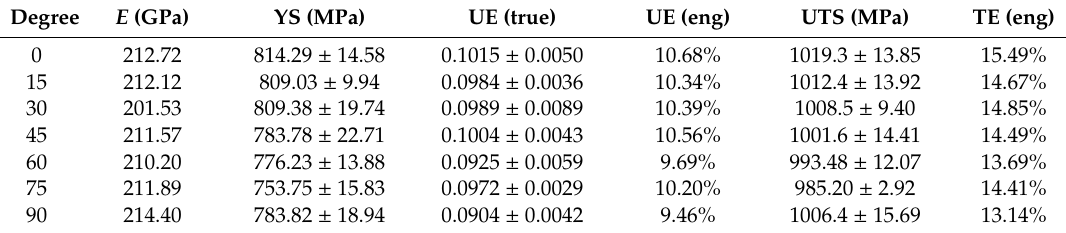
Table 1. Measured elastic and plastic properties of the Q&P980